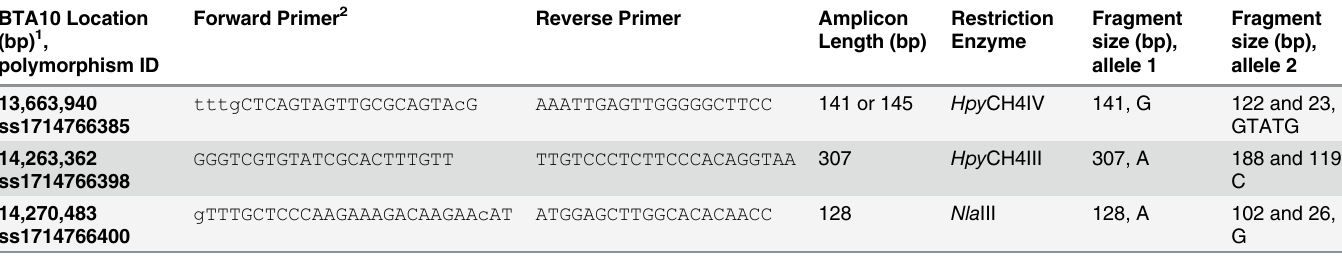
Table 1. PCR-RFLP assays.